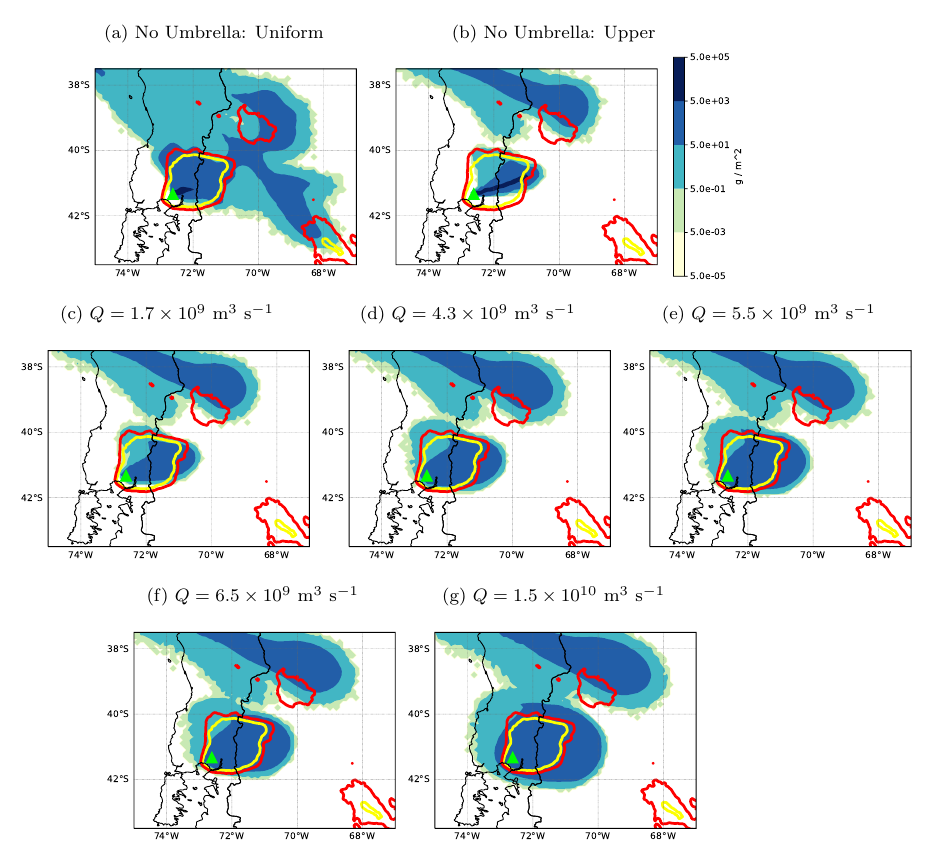
Figure 3. Modelled ash column loads (filled contours in g m − 2 ) and GOES-13 brightness temperatures in the 11 µ m channel (open contours: yellow (225 K) and red (255 K)) of the Calbuco ash cloud at 07:08 UTC on 23 April 2015 (3 h 8 min after the start of Phase 2). Model simulations in ( a , b ) do not use the umbrella cloud parameterisation and are described in Section 5. Simulations in ( c – g ) use the umbrella parameterisation with different estimates of the volume flow rate, Q . The volcano location is marked by a green